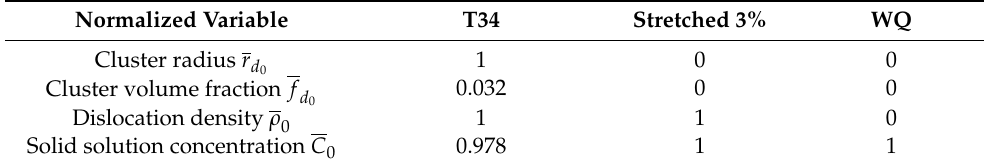
Table 3. Initial values of microstructural variables according to different